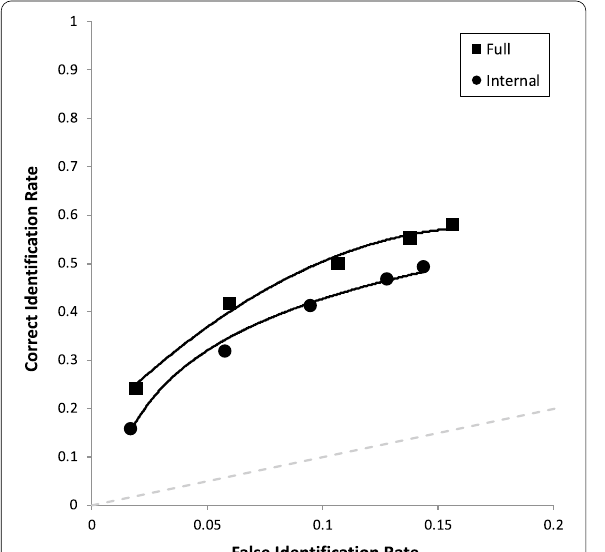
Fig. 7 ROC curve for each showup condition broken down by encoded and test face type. Full For example, Full-INT represents a full face presented at encoding, followed later by internal face